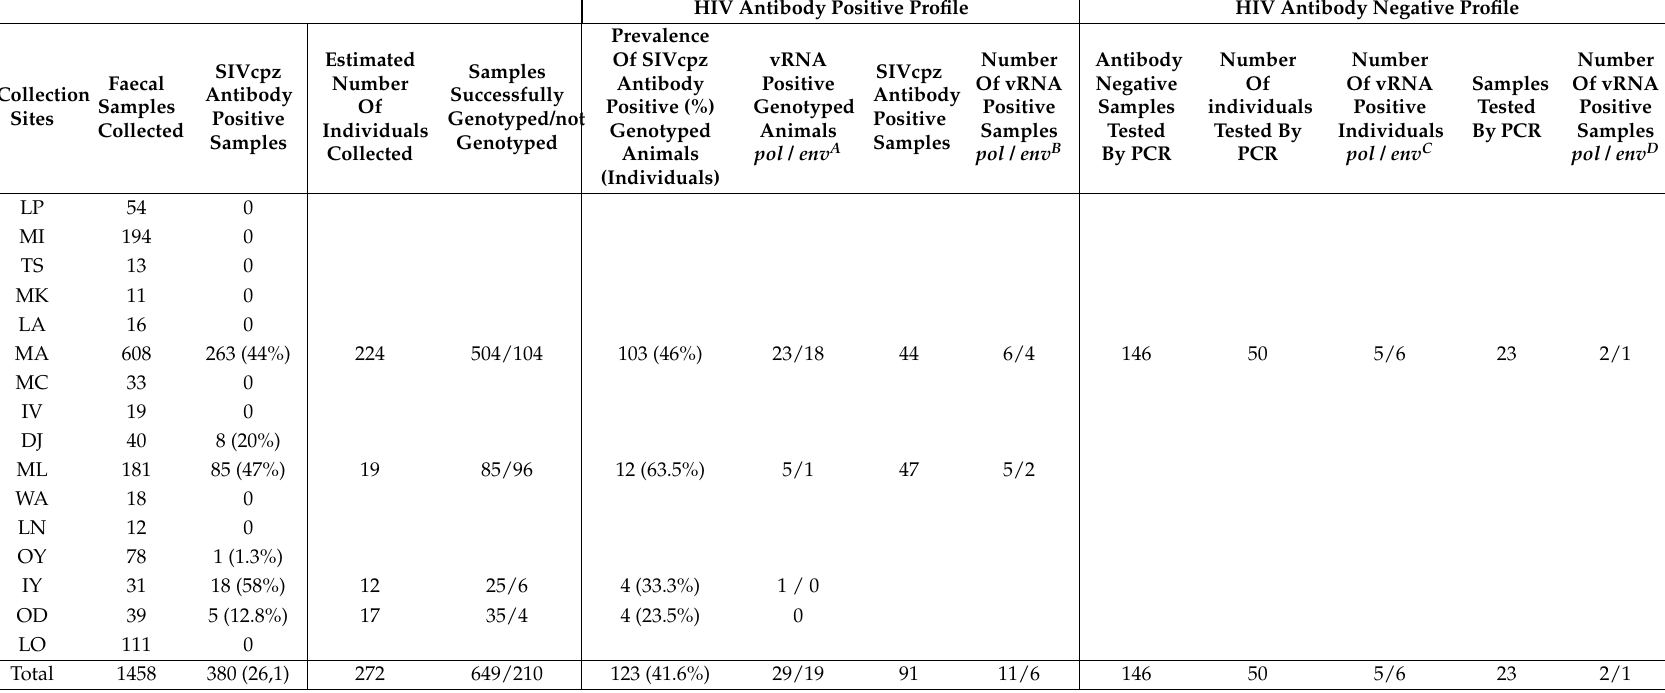
Table 1. Crude and corrected estimations of Simian Immunodeficiency Virus (SIV) infection rate in wild chimpanzees from different field sites in Gabon